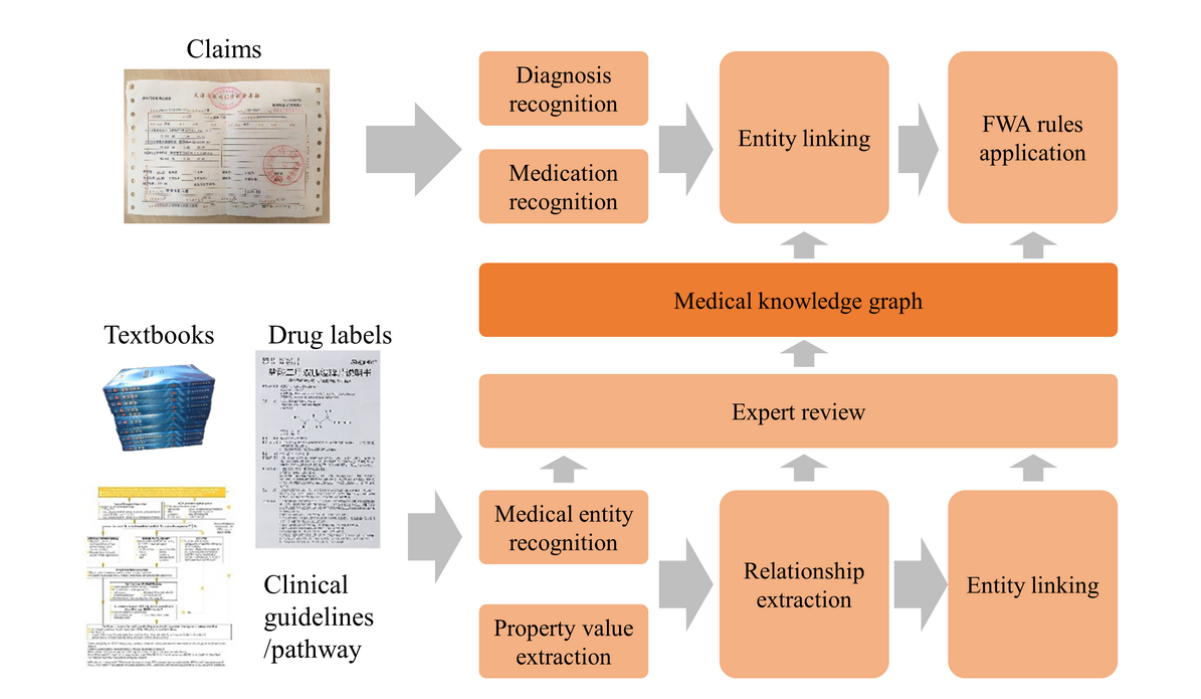
Figure 1. Overview of our methodology. FWA: Fraud, Waste and Abuse.